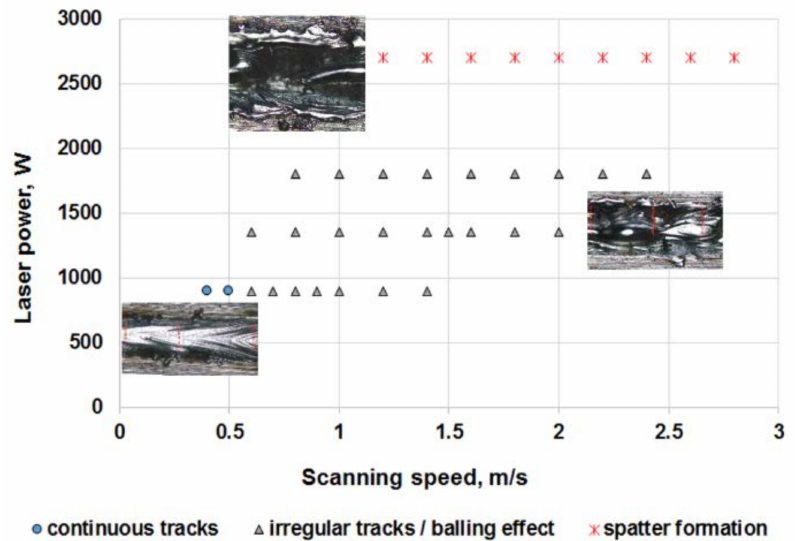
Figure 4. Process map obtained on 900–2700 W laser power and 240 µ m laser spot diameter (“high-power system”).